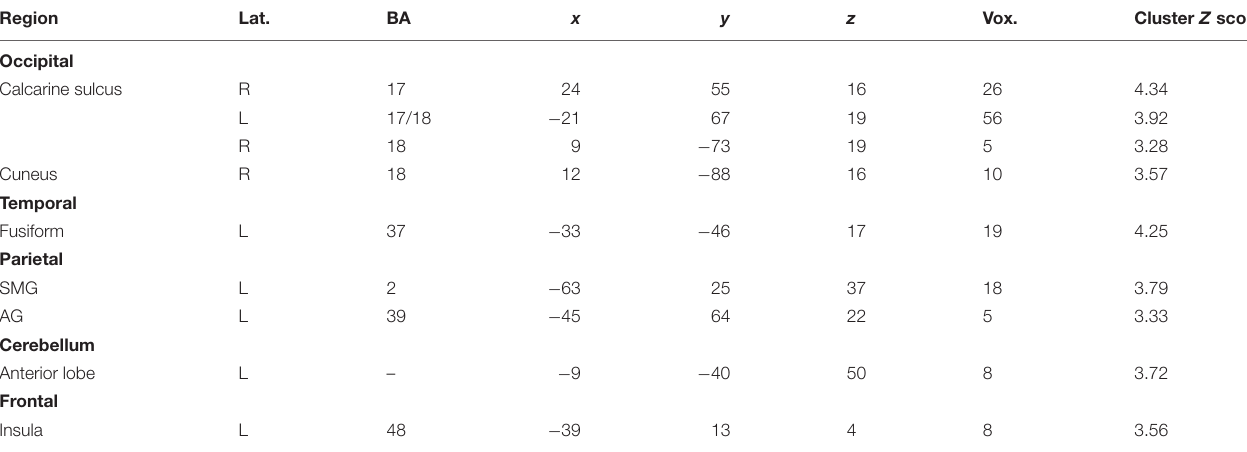
TABLE 6 | Regions which show a no-think-couple/think-decouple relationship with left posterior hippocampus. Region Lat. BA x y z Vox. Cluster Z